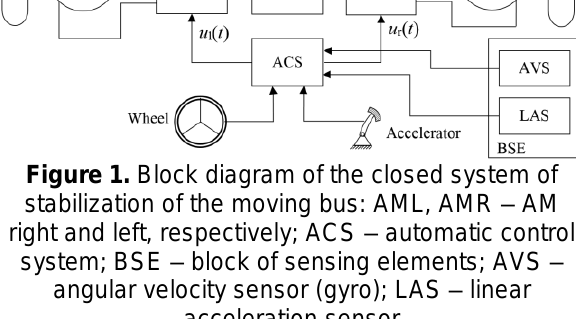
coincides with the main central axes of inertia of the bus angular orientation of the housing relative to the given three sensors of linear acceleration of the housing relative to the same axes are used. The alignment of the trajectory of the electric bus is carried out not by turning the wheels, but by changing the speed of rotation of one wheel relative to the